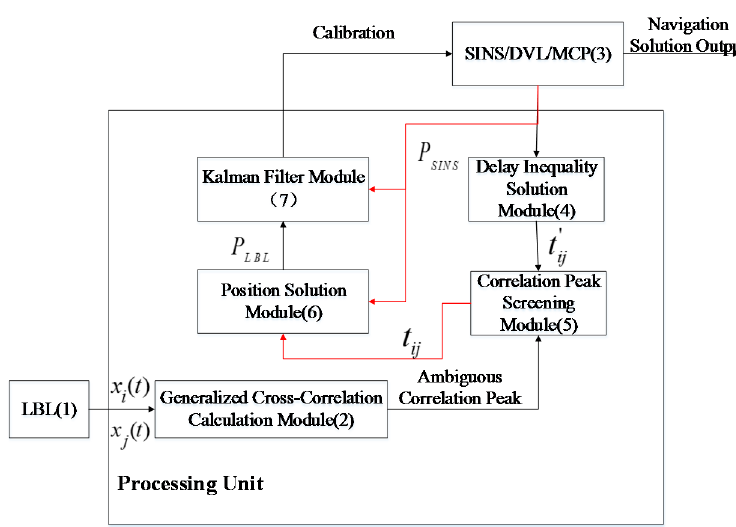
Figure 4. Operation principle block diagram of the system. SINS, strapdown inertial navigation system; DVL, Doppler velocity log; MCP, magnetic compass pilot.